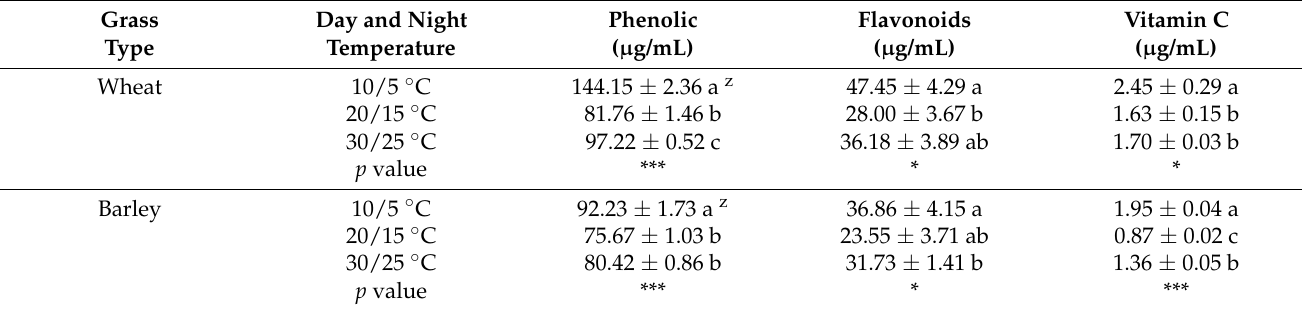
Table 2. Bioactive compound contents of wheat and barley grass extracts treated at different day and night temperatures. Grass